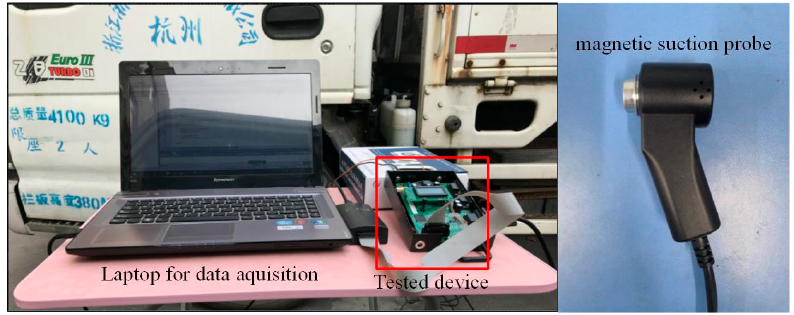
Figure 5. Photo of test scenario and device.